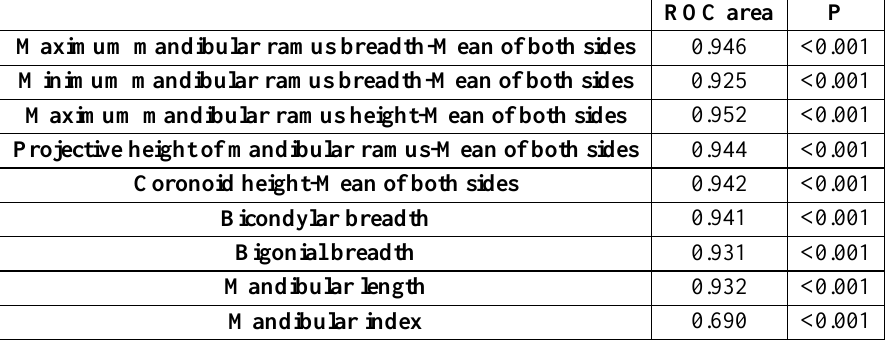
Table 5: ROC area for selected bilateral linear measurements of mandibular ramus when used as test for gender identification ROC area P Maximum mandibular ramus breadth-Mean of both sides 0.946 Minimum mandibular ramus breadth-Mean of both sides Projective height of mandibular ramus-Mean of both sides Coronoid height-Mean of both